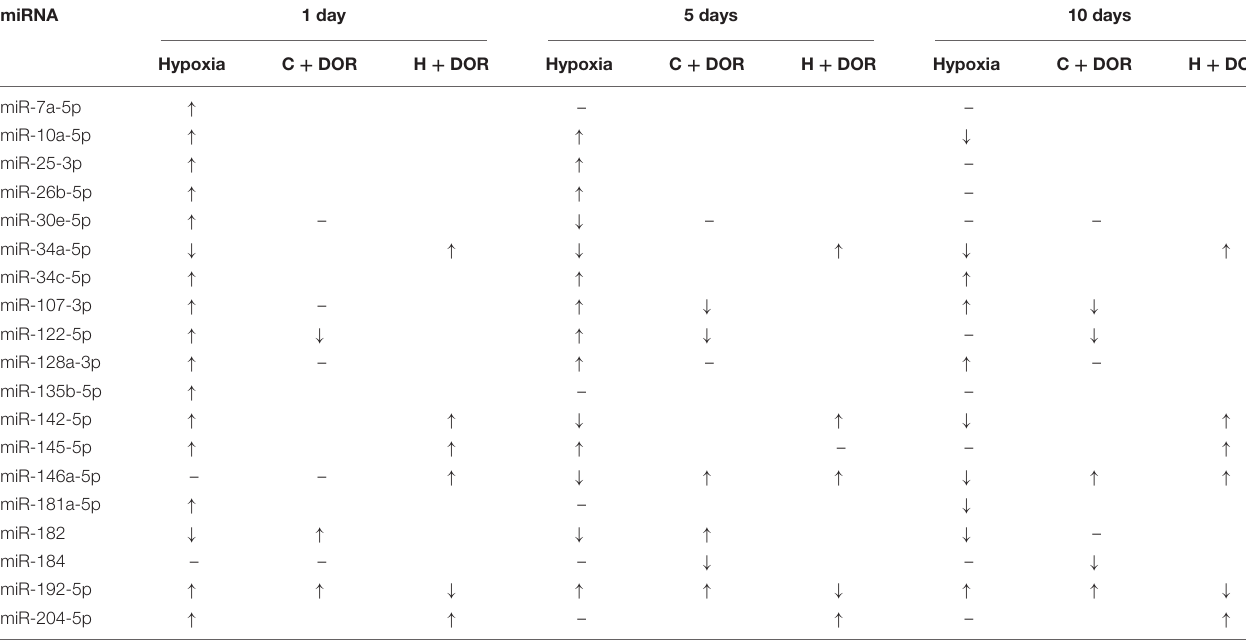
TABLE 9 | Effects of DOR activation on liver miRNAs in prolonged hypoxia.